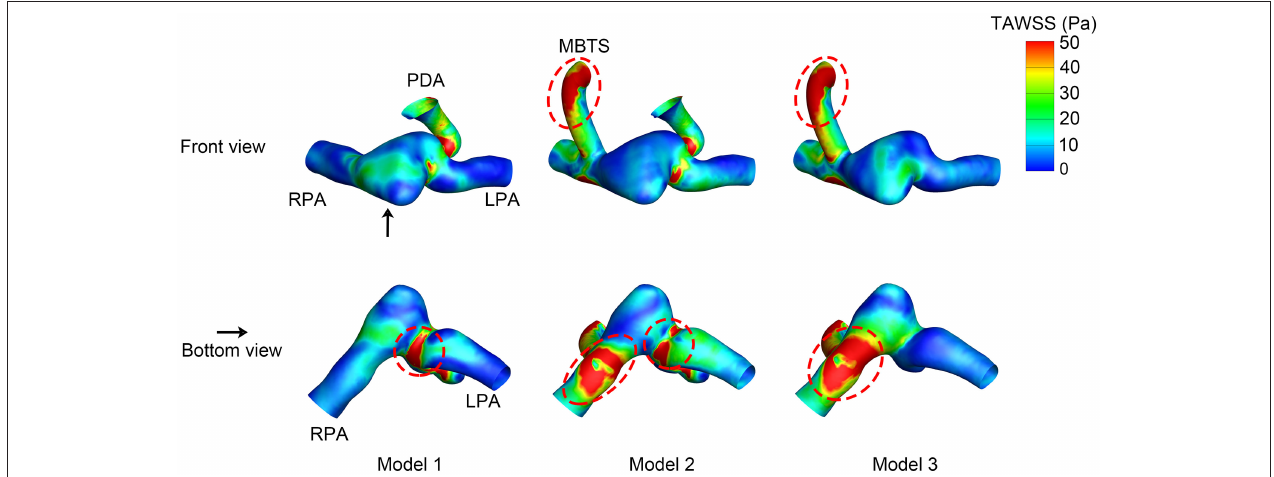
FIGURE 5 | Time-averaged wall shear stress (TAWSS). The upper row is the front view, and the lower row is the bottom view of each model except for the aorta. The black arrow indicates the perspective of the bottom view. PDA, patent ductus arteriosus; MBTS, modified Blalock-Taussig shunt; LPA, left pulmonary artery; RPA, right pulmonary artery.